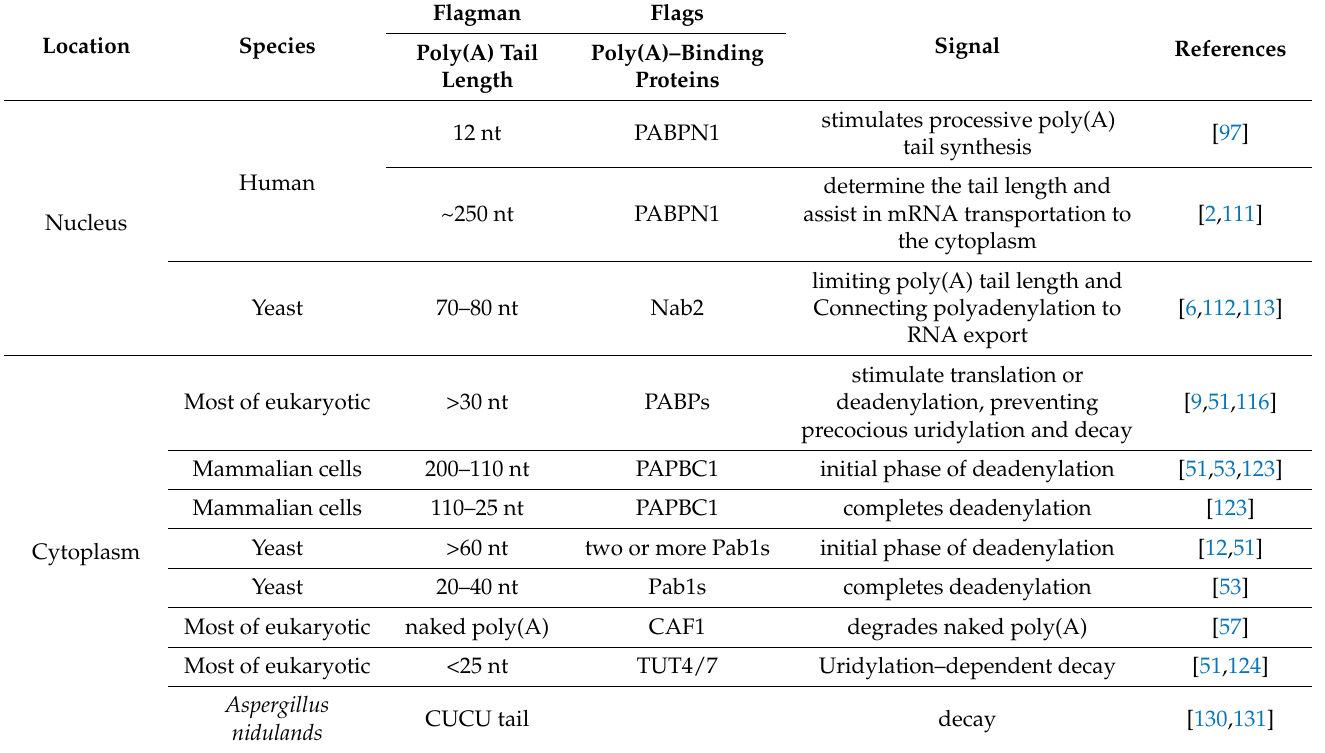
Table 1. Signals provided by poly(A) tail hub, singly and